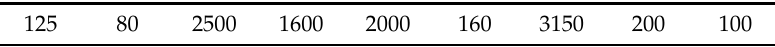
Table 5. Variables selected (Frequency,